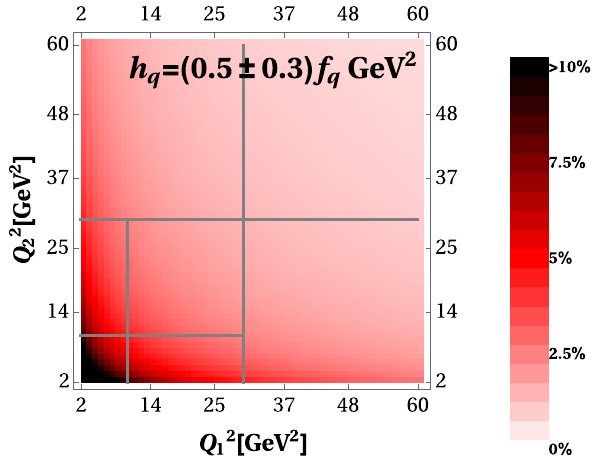
Fig. 5 The cross-section variation with respect to the change of the twist-3/4 parameter h q η (cid:2) in the ( Q 2 ning of the data. The variation of cross-section by changing parameter δ q ± 0 . 1GeV is practically the η (cid:2)